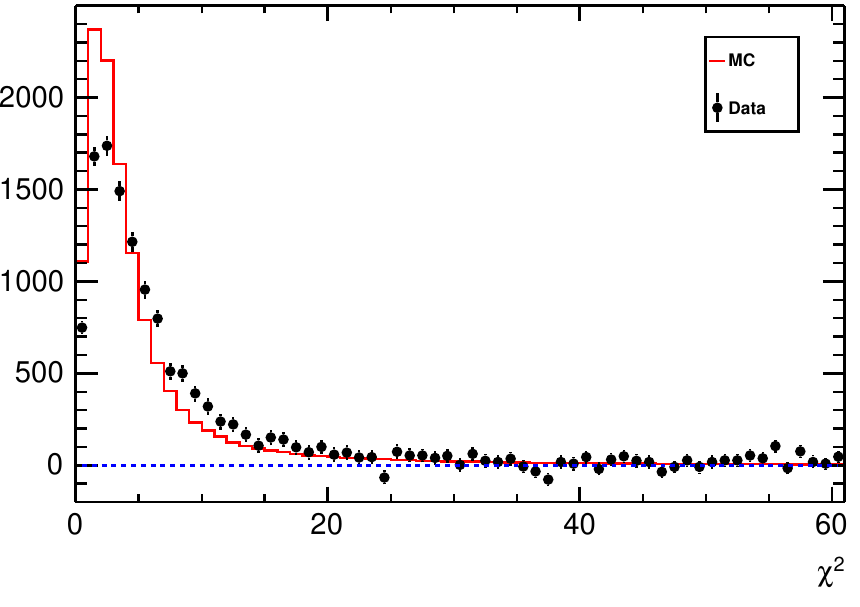
Figure 2 . (cid:31) 2 of the kinematic (cid:12)t under the e + e (cid:0) ! (cid:25) + (cid:25) (cid:0) (cid:13)(cid:13) hypothesis (points with error bars) and simulated e + e (cid:0) ! (cid:17)(cid:25) + (cid:25) (cid:0) events (histogram) from the energy range 5 (cid:17)(cid:25) + (cid:25) (cid:0) event yield and background